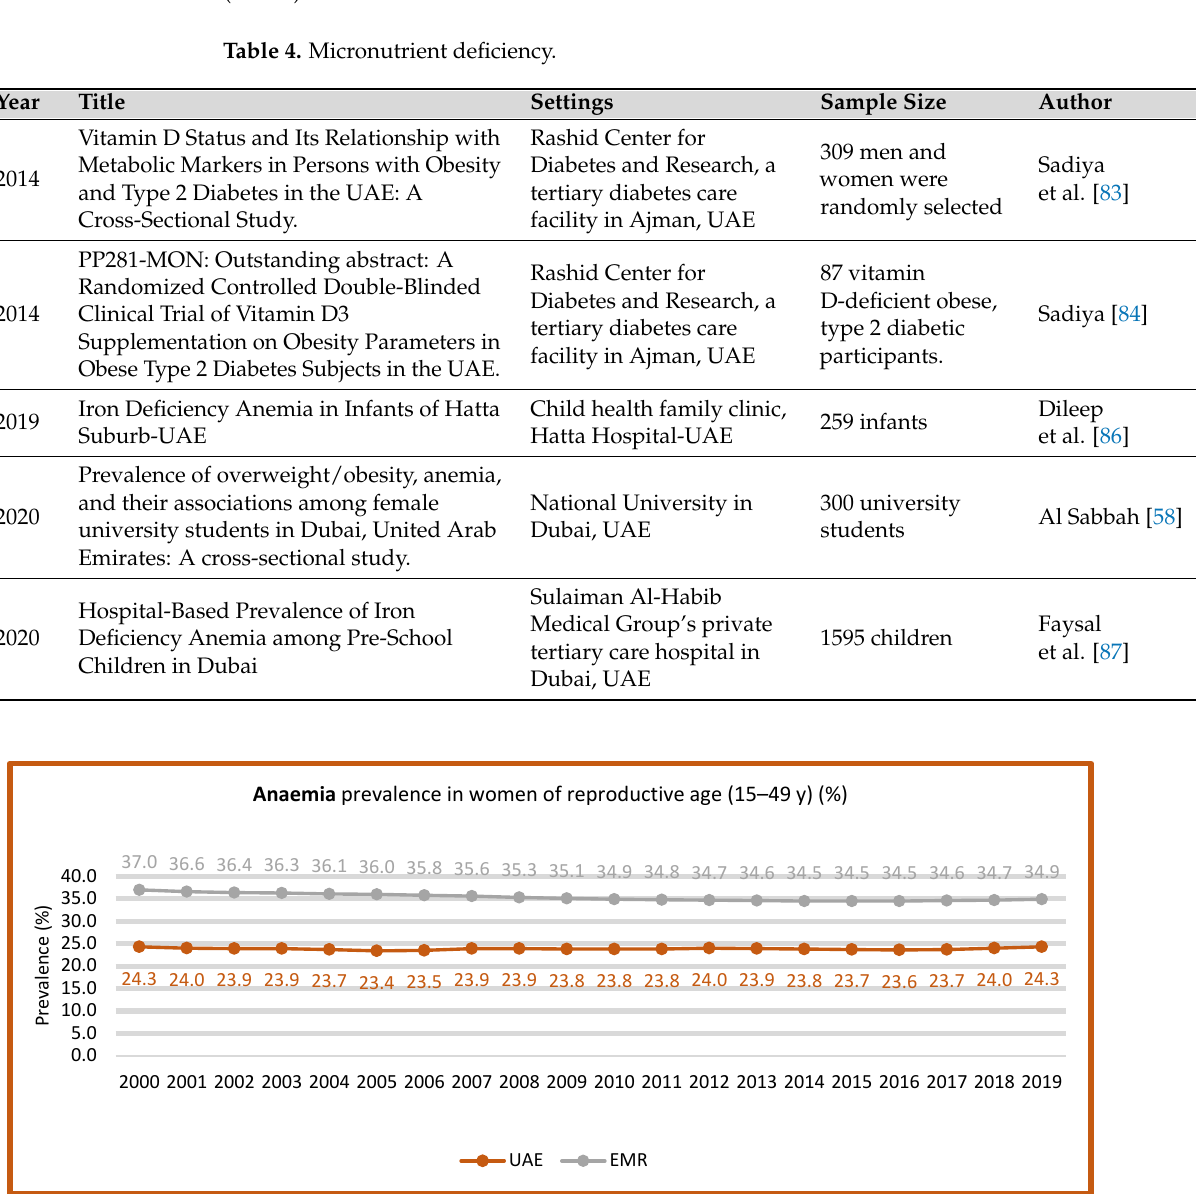
Figure 8. Trends of iron deficiency anemia prevalence among women of reproductive age (15 – 49 years of age) (2000 – 2019). Source: https://www.who.int/data/gho/data/themes/topics/anaemia_in_women_and_children (accessed on 5 December 2022) [26].